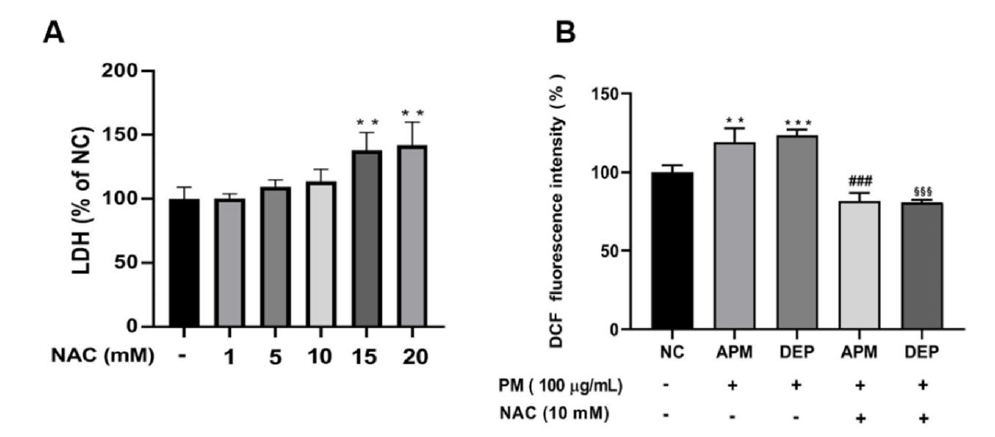
Figure 2. Artificial particulate matter (APM) and diesel exhaust particles (DEP) induce oxidative stress in alveolar macrophages (MH − S). ( A ) Cytotoxicity of N − Acetyl Cysteine (NAC). ( B ) Reactive oxygen species level was measured using 2 ′ ,7 ′− dichlorofluorescein diacetate (DCF − DA) staining. Negative controls (NC) are untreated samples. MH − S was pretreated with NAC for 3 h and was stimulated with 100 μ g/mL APM or DEP for 3 h. Data are presented as the means ± SD (n = 4 per group). ** p < 0.01, or *** p < 0.001 vs. NC; ### p < 0.001 vs. APM; §§§ p < 0.001 vs. DEP group. 3.3. Effect of Coconut Oil on Cytotoxicity and Oxidative Stress in PM ‐ Stimulated AMs To investigate the effect of coconut oil on cytotoxicity, and its antioxidant activities in PM ‐ stimulated AMs, we determined the concentrations of DW as a vehicle control, and of coconut oil without cytotoxicity. Our results showed that there was no change in cell viability up to 10% DW in complete medium (Figure 3A). Since there was no change in cell viability, up to 0.05% coconut oil in coconut oil ‐ treated AMs (Figure 3B), and 0.0125% and 0.025% concentrations were chosen, for testing the efficacy of coconut oil in the in